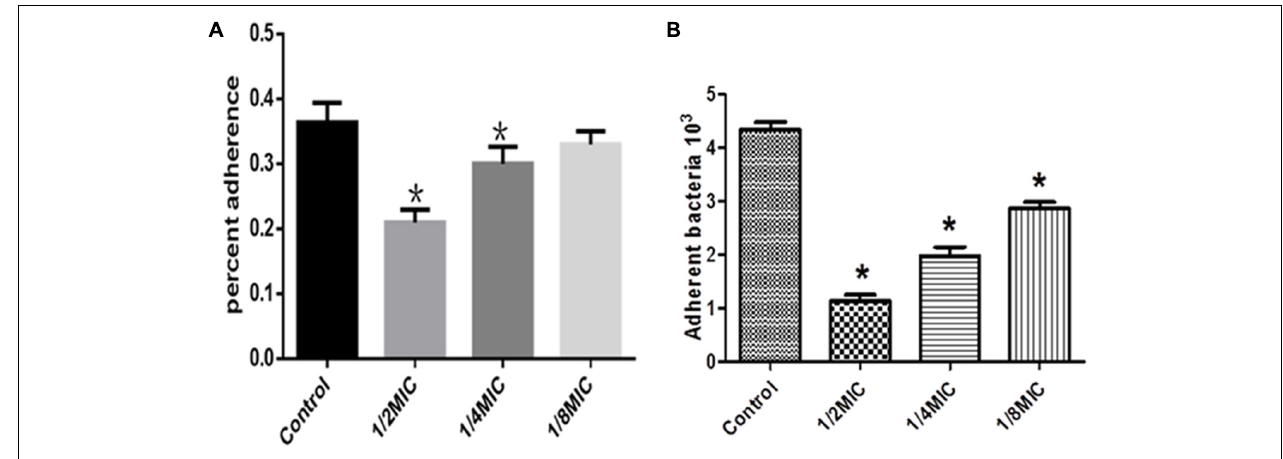
FIGURE 4 | Effect of Rhizoma Coptidis at different concentrations on S. suis ATCC700794 adhesion to glass (A) , or PK-15 cells (B) . Data are expressed as means ± standard. Significant decrease ( ∗ p < 0.05) compared to control in vitro .